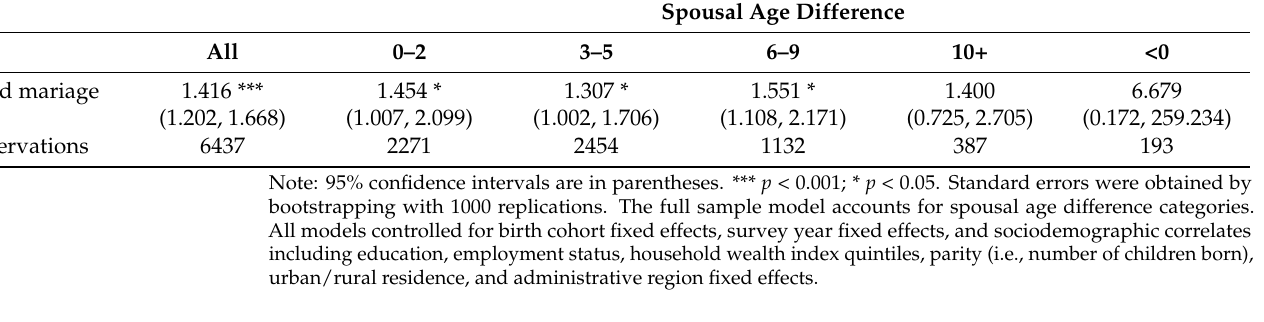
Table 8. Quantile regression results for body mass index for the full